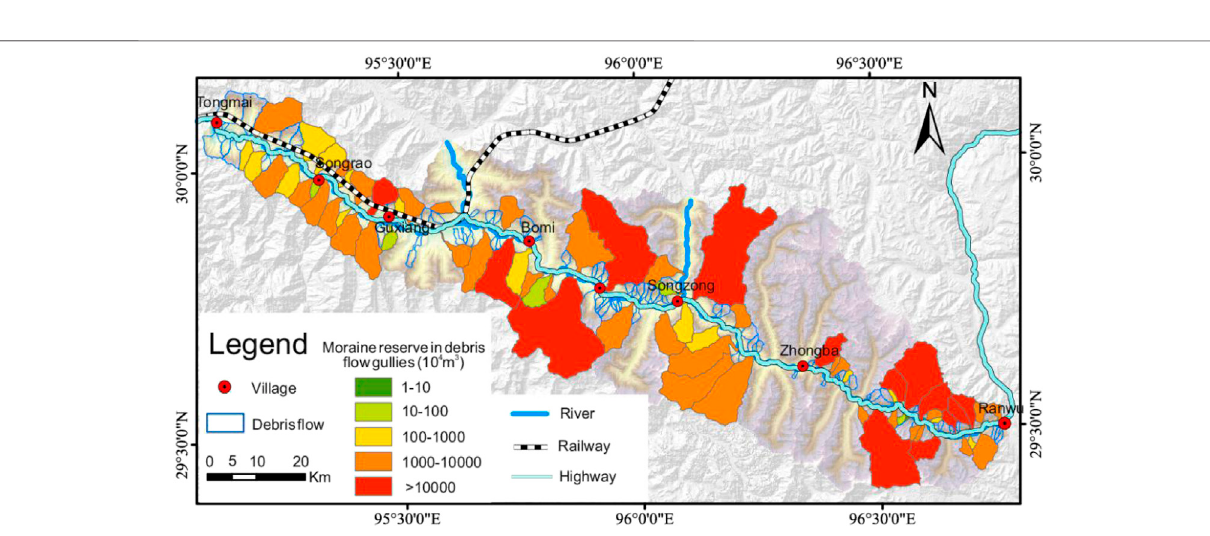
Frontiers in Earth Science |